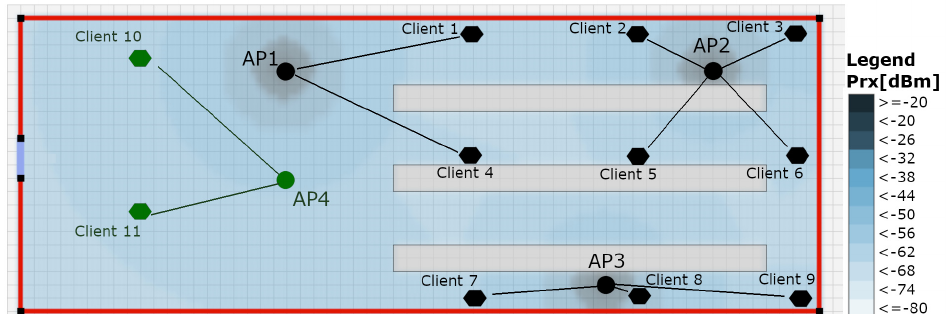
Figure 11. Initial network-planning result for WiFi and SDR APs in an IIoT lab measuring 11 m by 30 m. Clients are represented by hexagons and APs are represented by circles. The color indicates the wireless technology (green = SDR, black = WiFi). The lines indicate to which AP the clients are connected.